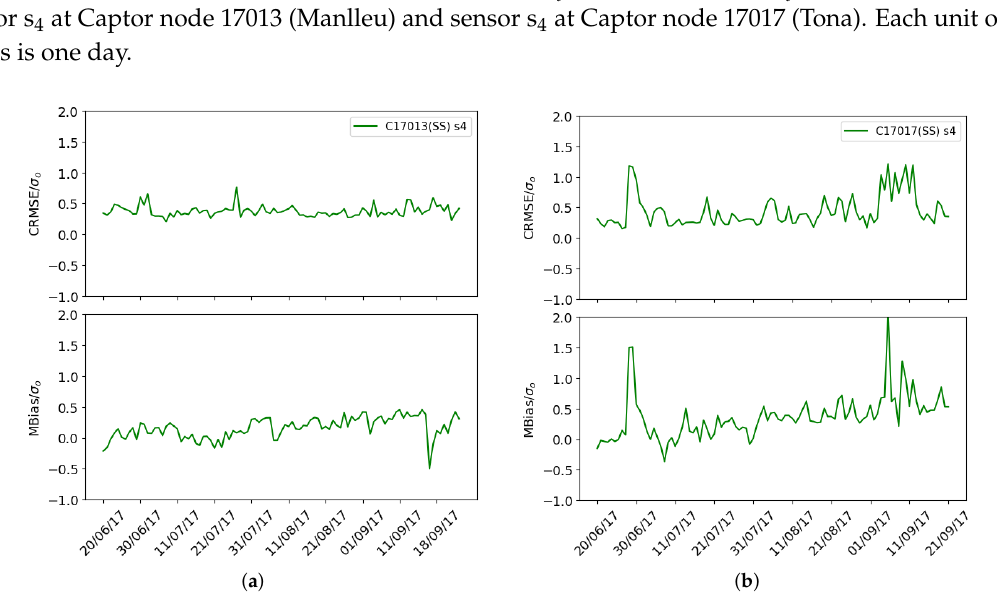
Figure 12. Mean normalized bias and normalized centred CRMSE: ( a ) sensor s 4 Captor 17013 (Manlleu), ( b ) sensor s 4 Captor 17017